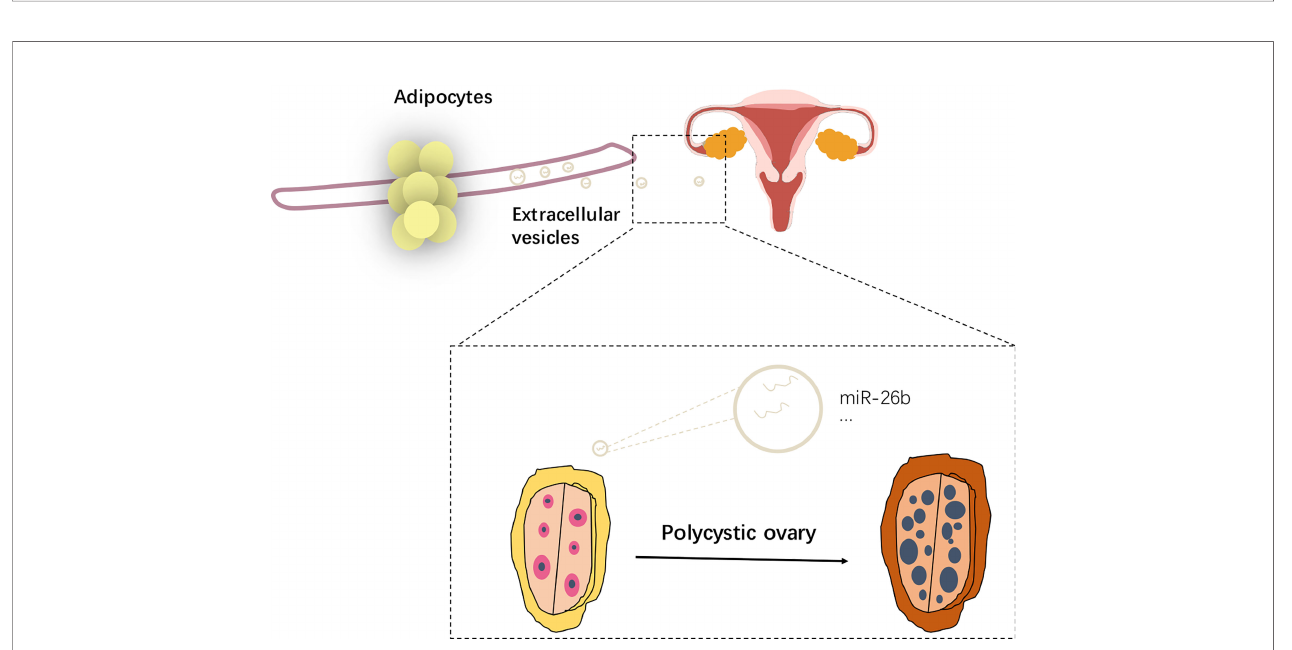
FIGURE 11 | Schematic diagram showing the impact of extracellular vesicles derived from adipocytes in